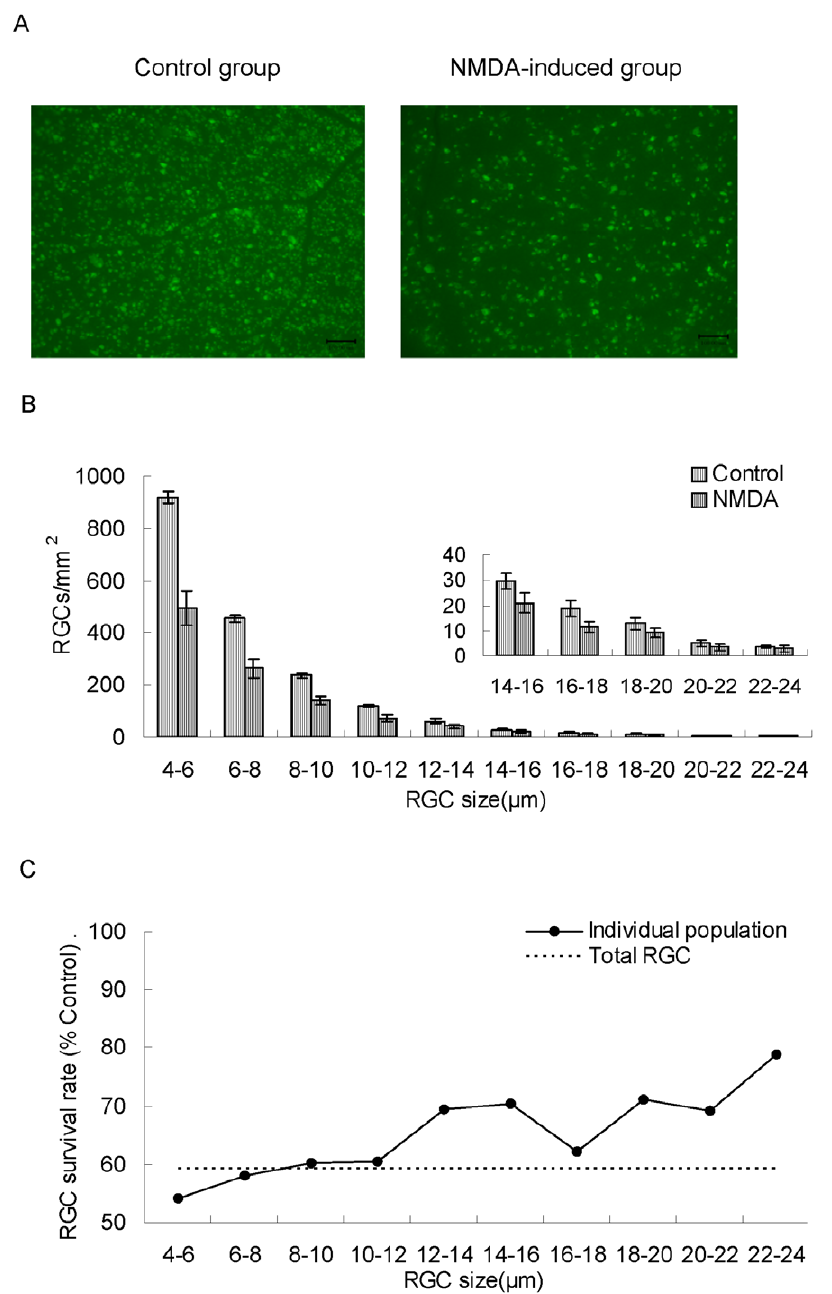
Figure 1. Flatmount quantification of rat RGCs by image analysis software. Seven days post-treatment with intravitreal injection of vehicle (BSS as control) or NMDA solution. (A). Image of FG-labeled RGCs in flatmounted retina, bar=100 m m. (B). Soma size distribution histograms. The histograms were generated by counting 10000 RGC cells and dividing into size groups with a 2 m m interval. RGC density was expressed as RGCs/mm 2 (mean 6 SEM, n=8). (C). RGC survival rates of different size groups after intravitreal NMDA (40 mM, 2 m L) treatment. Each point represents RGC survival rate (%) based on the individual RGC size population of control group, the dashed line represents total RGC survival rate (%). doi:10.1371/journal.pone.0033983.g001 nation with the coefficients of variation 0.20 , 3.32% (data not shown). A linear equation was used to fit a calibration curve of microsphere diameter versus FSC value: y= 0.027x + 2.16 (eq. 2), where x = FSC value; y =microsphere diameter, with a unit of micrometer. The fitted equation had good linear relationship (r = 0.9883, Fig. 3B) to be applied for calculating the D (v, Q) of RGCs.